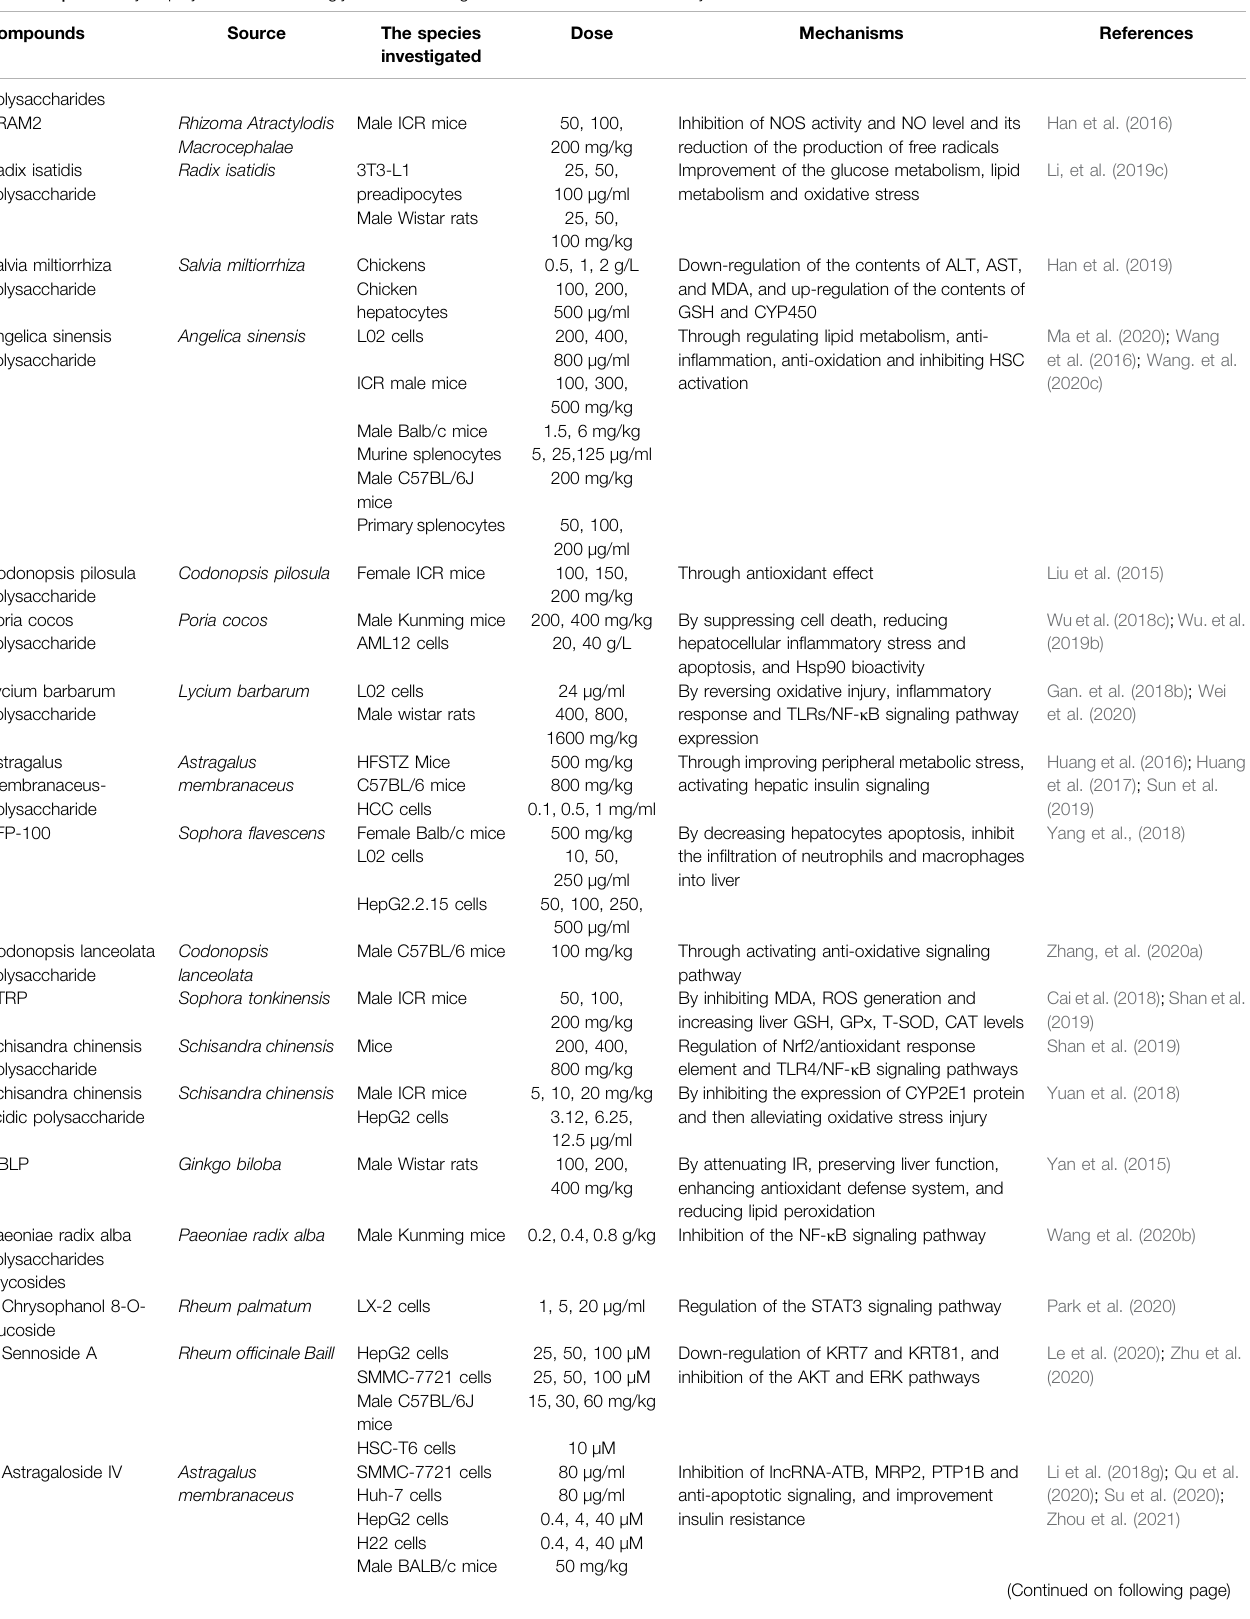
TABLE 2 | Summary of polysaccharides and glycosides with signi fi cant anti-liver disease activity.